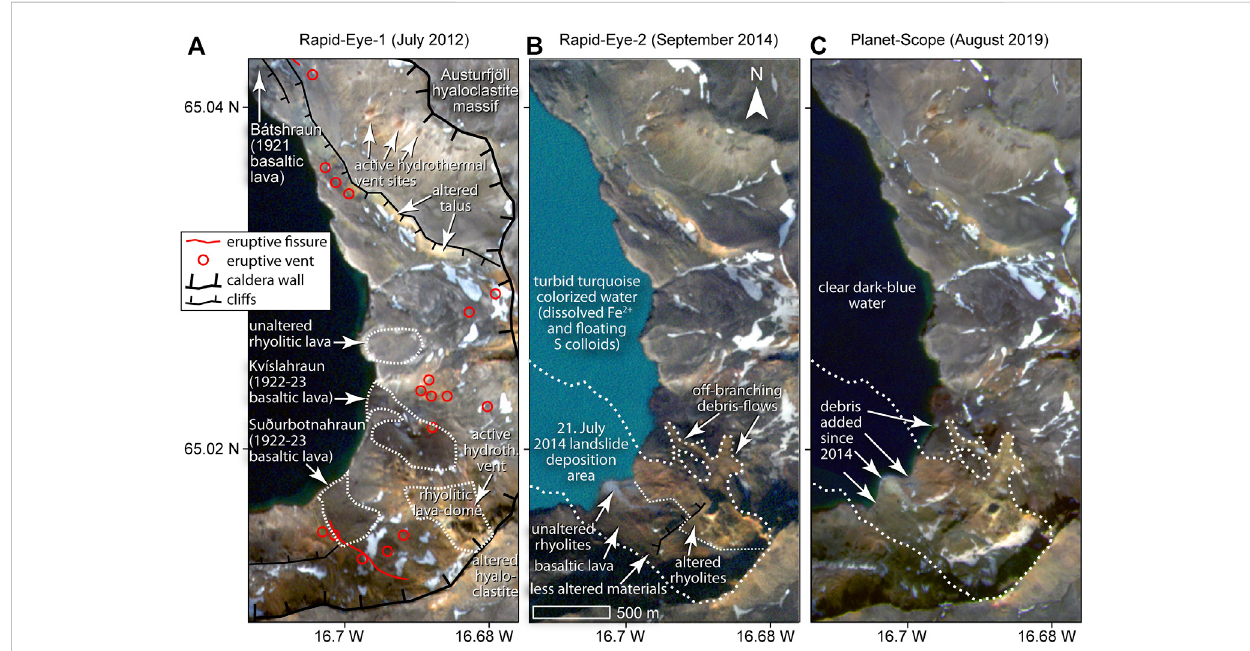
FIGURE 3 Very High Resolution (VHR) satellite images of the study area. (A) RapidEye-1 before (16 July 2012) and (B) RapidEye-2 after the landslide (6September2014)and (C) PlanetScopeonly24 dayspriortoourdronesurvey(4August2019).Hydrothermallyaffectedareasappearinrustyredcolors. (A) Locations of the 1920 basaltic lava fl ows and two rhyolitic lava domes in the SE sector of the caldera are indicated. Corresponding eruptive vents and fi ssures — also those of older eruptions — are encircled in red, respectively indicated by red lines (locations adapted from Trippanera et al., 2018; Graettinger et al., 2019). (B) . (C) The deposition area of the 2014 landslide is outlined by a thick white dotted line (subaqueous landslide outlines adapted from Gylfadóttir et al., 2016), and preferentially deposited materials are indicated. Hydrothermally altered materials of the unroofed rhyolite lava dome were mostly deposited in the northern half of the landslide deposition area. The southern limit of deposition of yellow-brown hydrothermally affected rocksintherockslideisindicatedbyathinwhitestippledseparationline.Mostmaterialwasdepositedintheupperhalfoftheslopeformingapronounced morphological edge (black line) with respect to the downslope portion of the deposition area. (C) Locations of secondary downwash deposits formed along the coast since 2014. Selected scenes were least affected by snow and cloud